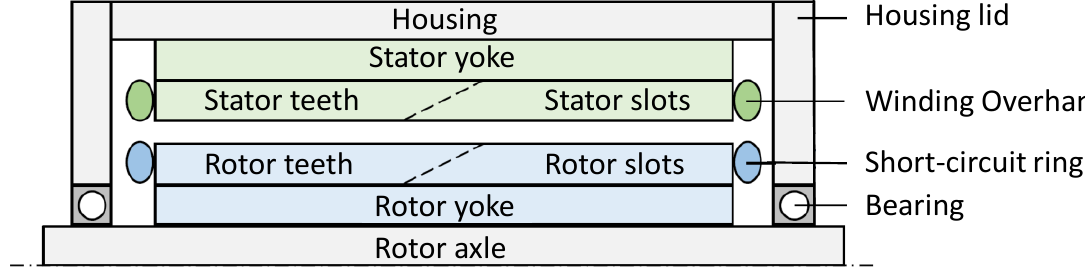
Figure 7. Individual components of the induction machine (IM) in a radial section.